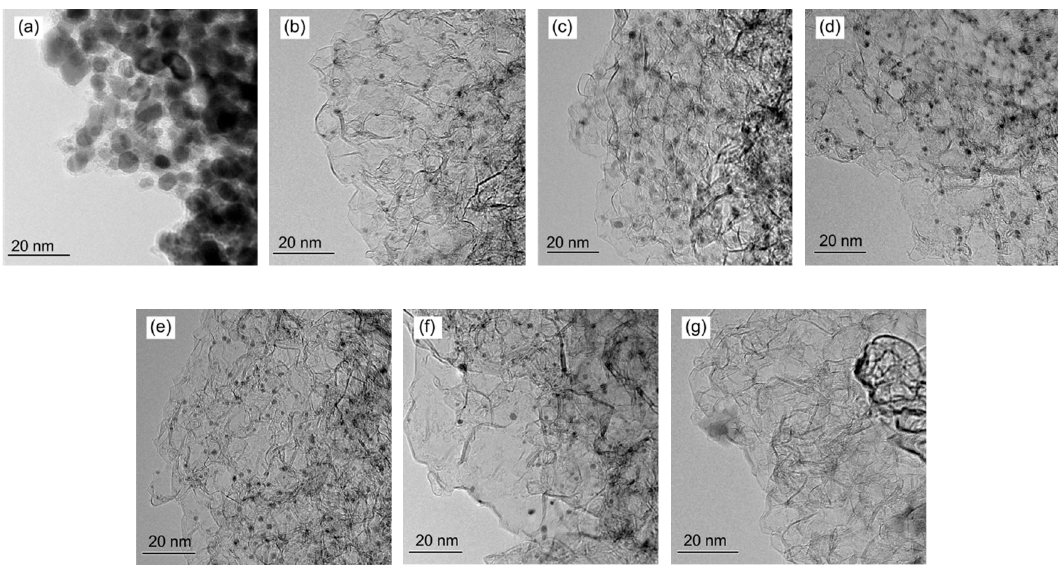
Figure 6. HRTEM images of the used Ba-Ru catalysts and reference materials: ( a ) 1.6Ba-10Ru/AC, ( b ) 1.6Ba-10Ru/MPC, ( c ) 1Ba-10Ru/MPC, ( d ) 0.5Ba-10Ru/MPC, ( e ) 0.1Ba-10Ru/MPC, ( f ) 10Ru/MPC, and ( g ) 1.6Ba/MPC.